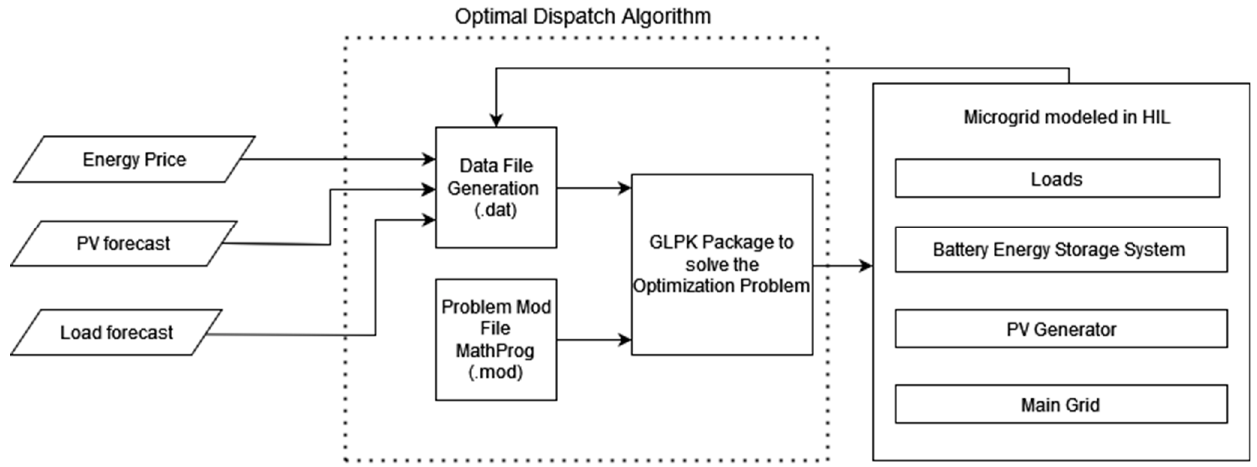
Figure 7. Block diagram for implementation of the optimal dispatch algorithm.